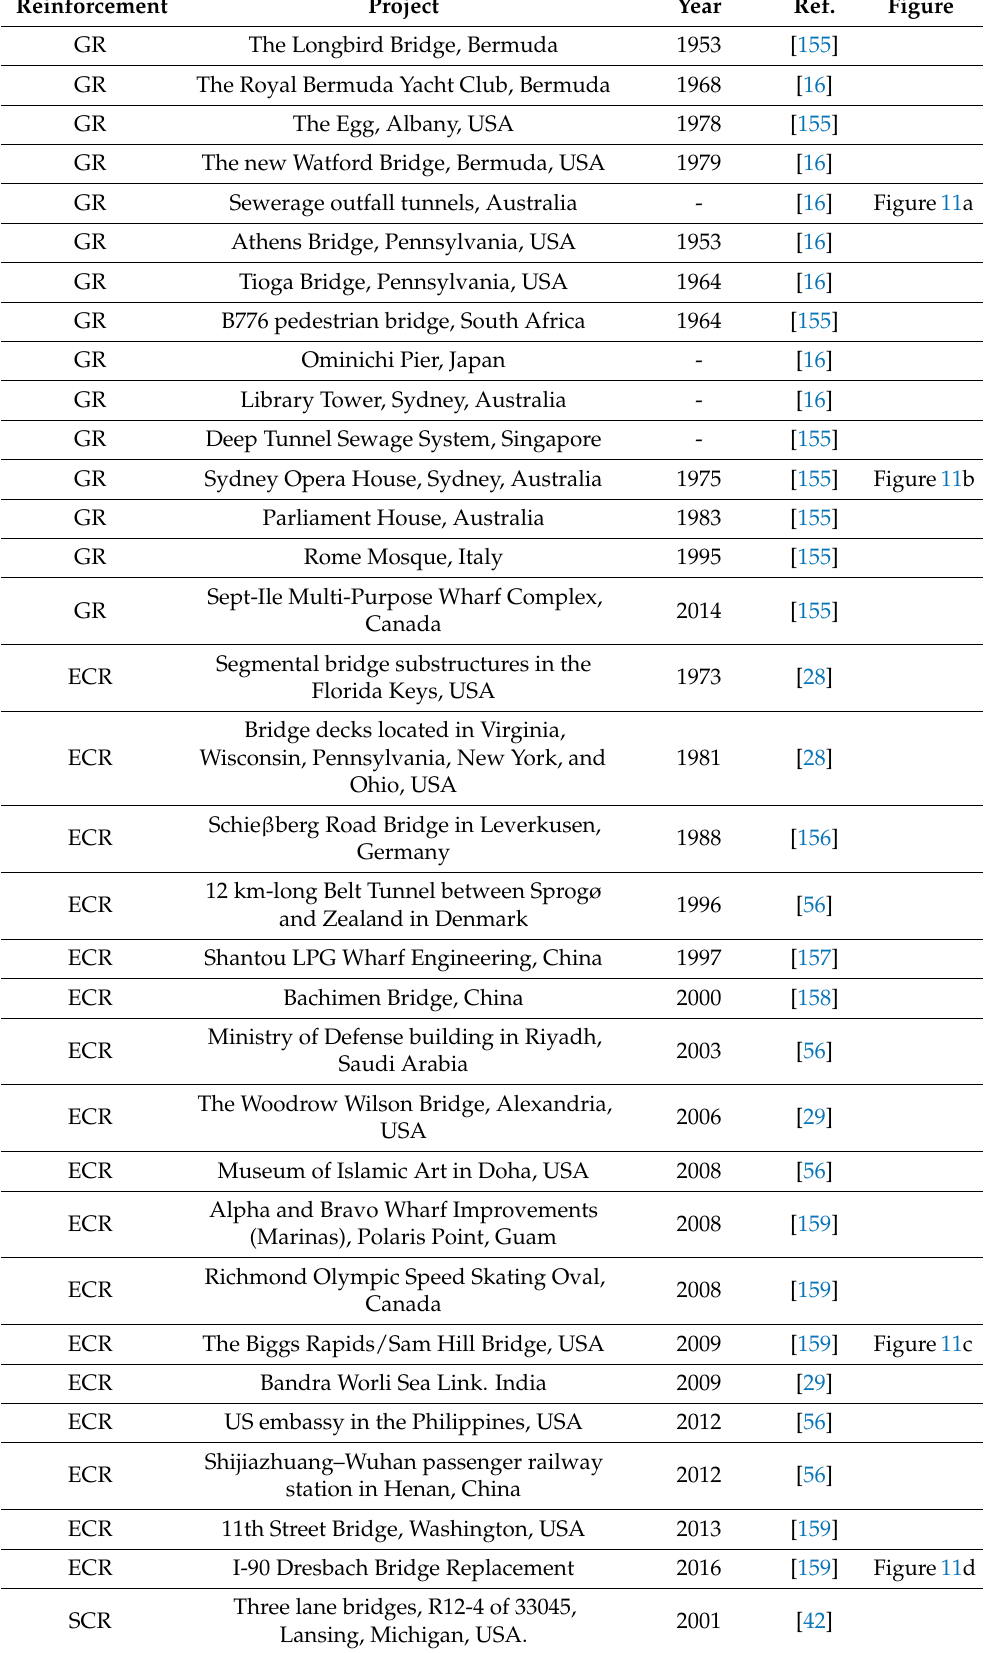
Table 8. Application of coated